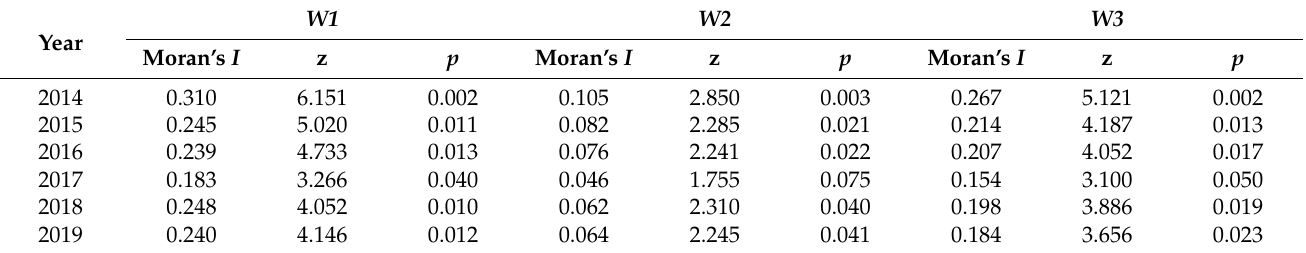
Table 5. Spatial autocorrelation analysis of the ACESs in counties based on global Moreland